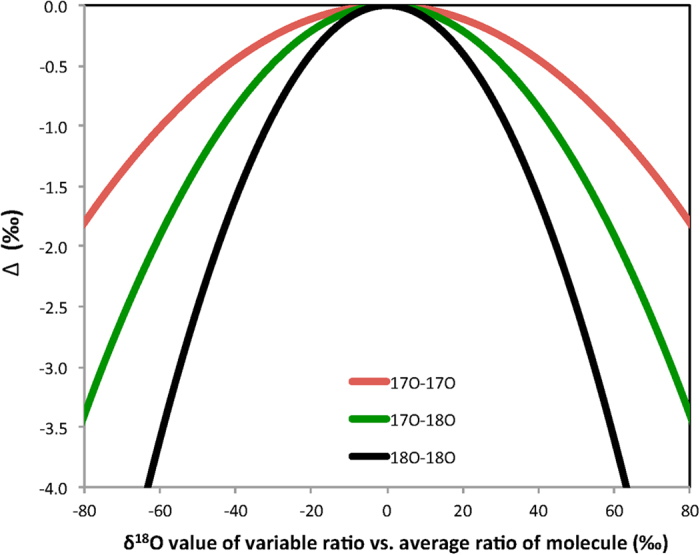
17O-17O, 17O-18O and 18O-18O clumping in O2 as function of the δ18O value of the variable isotope ratio versus the average isotope ratio in the molecule.Mass dependent fractionation according to  with three-isotope exponent β = 0.53 ref. 25 is assumed.